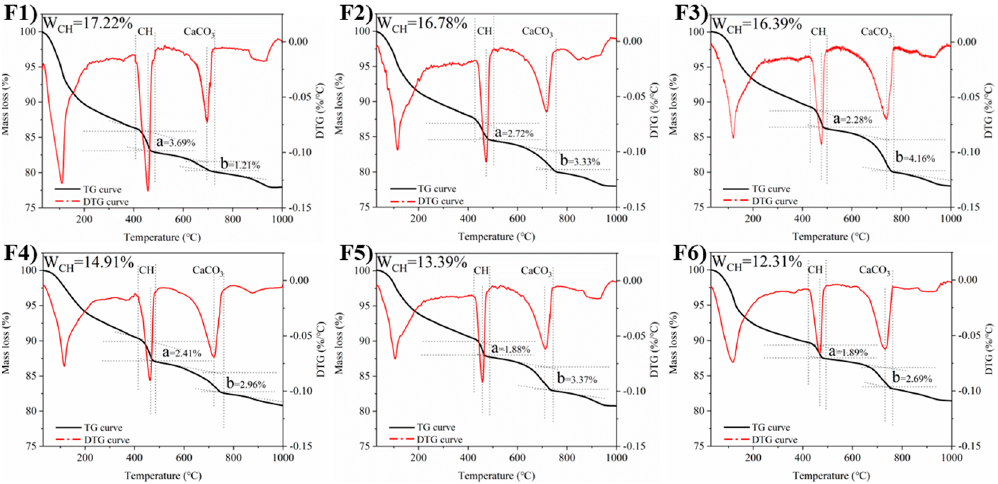
Figure 10. TG analysis of cement pastes before self-healing. (F1–F6 are the group numbers of cement particles with the average size 22.82 µ m, 29.78 µ m, 39.10 µ m 49.96 µ m, 60.51 µ m and 73.60 µ m, particles with the average size 22.82 μ m, 29.78 μ m, 39.10 μ m 49.96 μ m, 60.51 μ m and 73.60 μ m, respectively.)